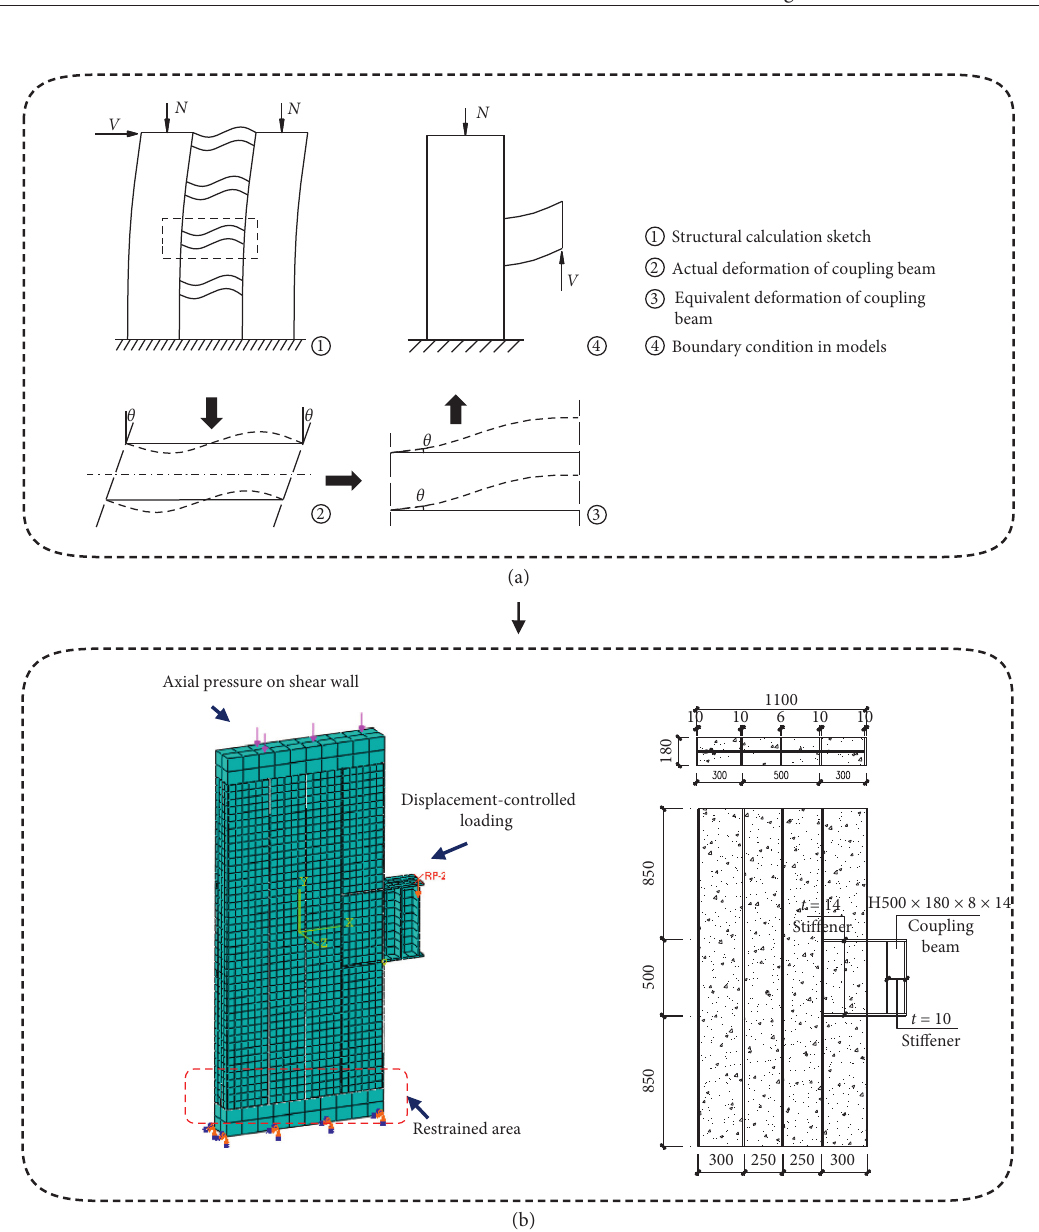
Figure 4: Basic welded connection (PEC-1). (a) Derivation of structural boundary conditions. (b) Structural boundary conditions and member dimensions in PEC-1.